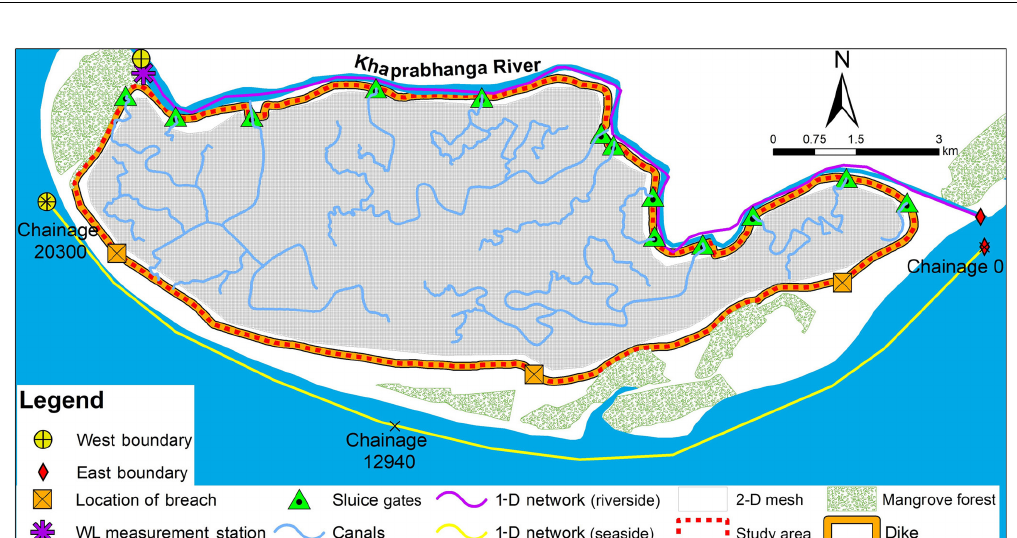
Figure 3. Schematic diagram of the study area with location of control structures and gauges and the considered breach